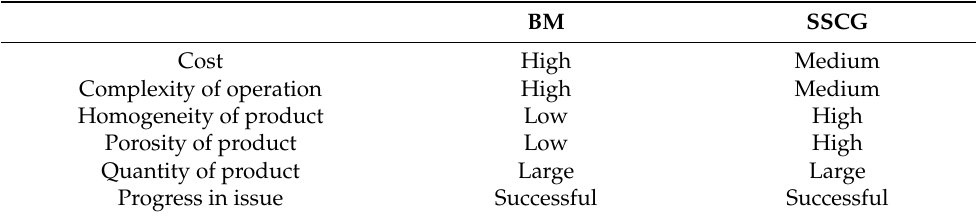
Table 1. Comparison between Bridgman method and SSCG method.